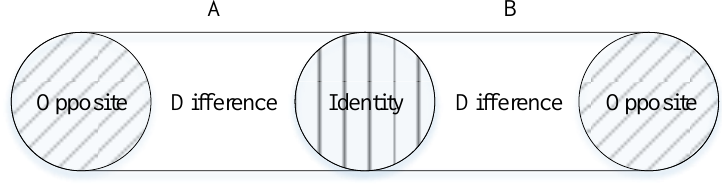
Figure 1. Identity, difference and opposite of two sets.